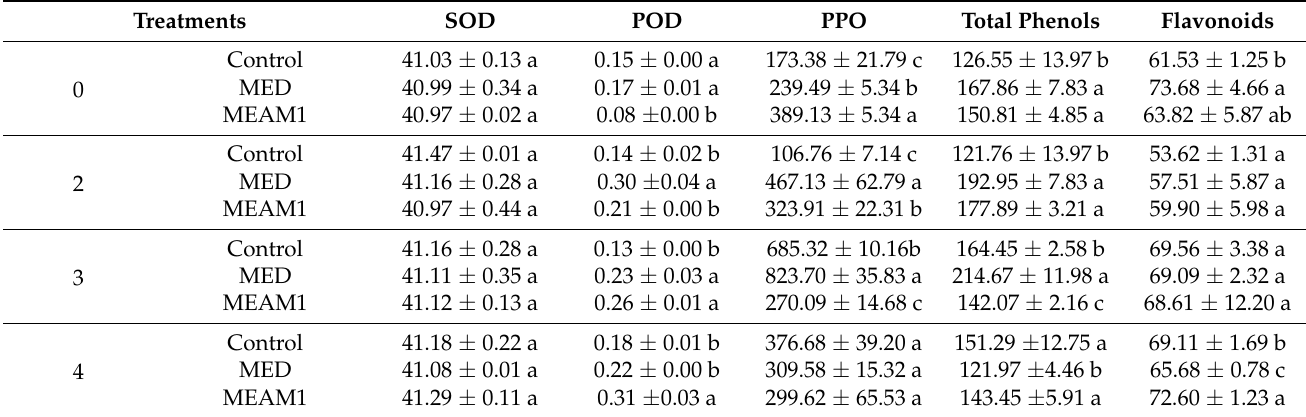
Table 2. Superoxide dismutase, peroxidase, polyphenol oxidase, total phenols, and flavonoids (mean ± SD) in tomatoes infested by Bemisia tabaci MED and MEAM1 and non-infested tomatoes (control), at each instar of the insect.